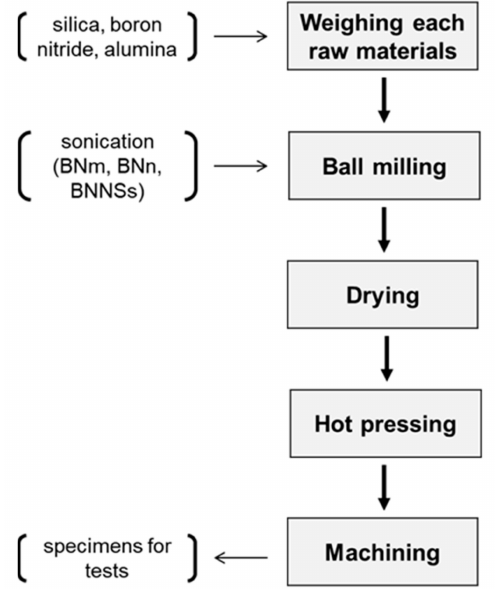
Figure 1. Flowchart of the sample